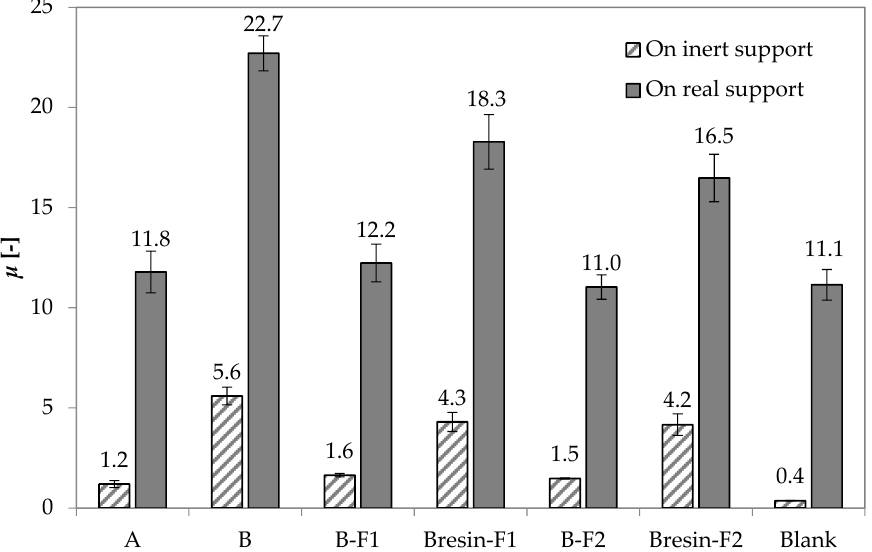
Figure 4. Water vapor diffusion resistance factor µ of paints applied on the real support or inert support. Blank is the support (real or inert) without coating.